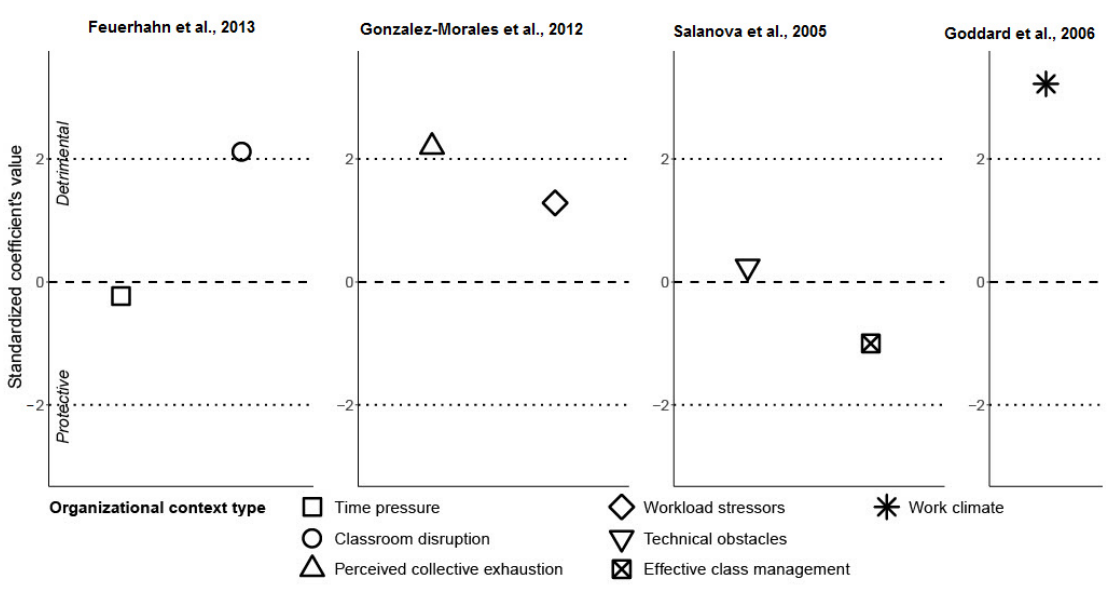
Figure 5. Studies showing burnout determinants belonging to the organizational context category (Feuerhahn et al., 2013; Gonzalez-Morales et al., 2012; Salanova et al., 2005; Goddard et al., 2006) [48,49,52,53].